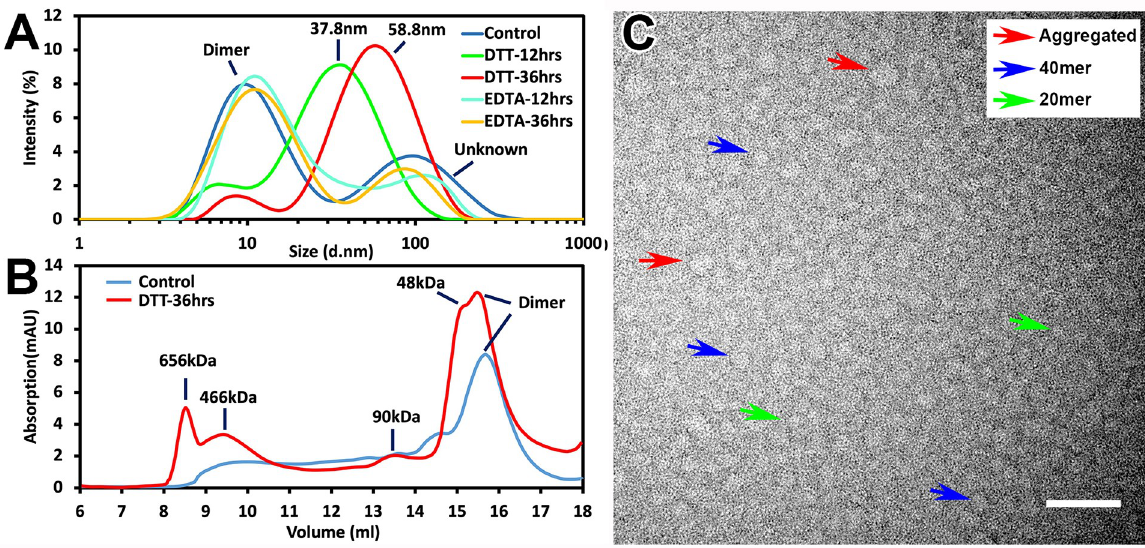
Fig 6. The effect of the DTT and EDTA on the oligomerization of hPER2c dimer. (A) The hydrodynamic size of hPER2c dimer monitored by DLS after incubation with DTT and EDTA for 12hrs and 36hrs. The peak for the dimer was labeled while the other additional peaks are labeled by their hydrodynamic diameters; (B) SEC chromatograms of DTT-treated hPER2c dimer (red line) and untreated one (blue line). The peaks of the dimer are labeled while the additional four peaks in the treated sample are labeled with their calibrated molecular weights; (C) The TEM image of DTT-treated hPER2c dimer. Molecules that resemble the hPER2c aggregation, 40mer, and 20mer were indicated using red, blue, and green arrows, respectfully.